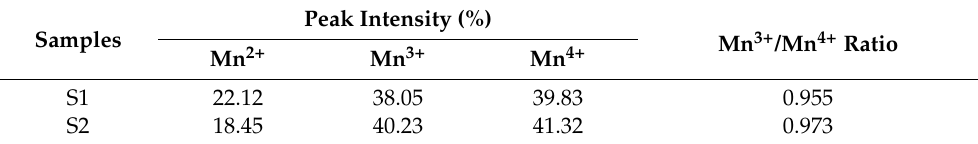
Table 3. XPS Mn2p 3/2 analysis of sintered